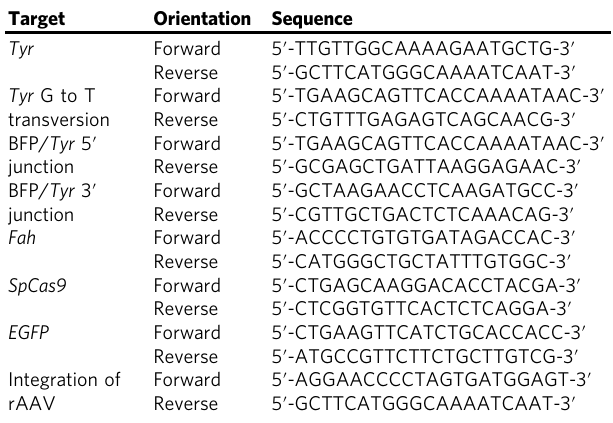
Table 6 List of primers used in PCR analysis